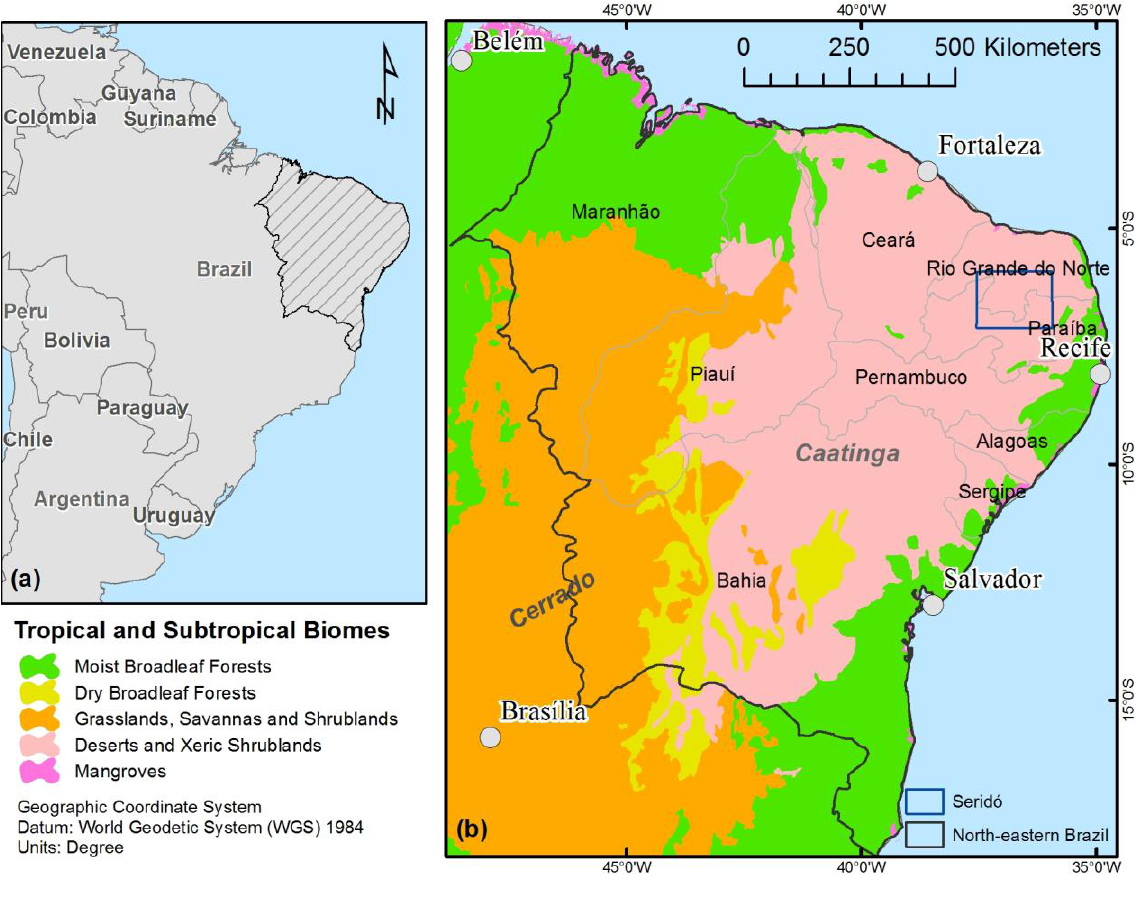
Figure 1 . ( a ) Overview of the study area of northeastern Brazil. ( b ) Tropical and subtropical biomes in northeastern Brazil are after Olson et al. [27], including the outline of the focus region